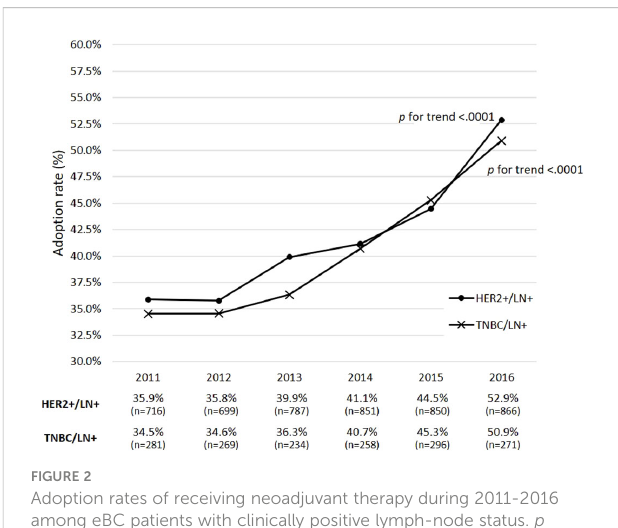
FIGURE 2 Adoption rates of receiving neoadjuvant therapy during 2011-2016 among eBC patients with clinically positive lymph-node status. p refers to the p -value for a time trend; a p -value of less than 0.05 indicates a signi fi cant change of adoption rates of neoadjuvant therapy over time. eBC, early breast cancer; BC, breast cancer; pCR, pathological complete response; HR, hormone receptor; HER2, human epidermal growth factor receptor-2; TNBC, triple-negative breast cancer; LN+, lymph-node